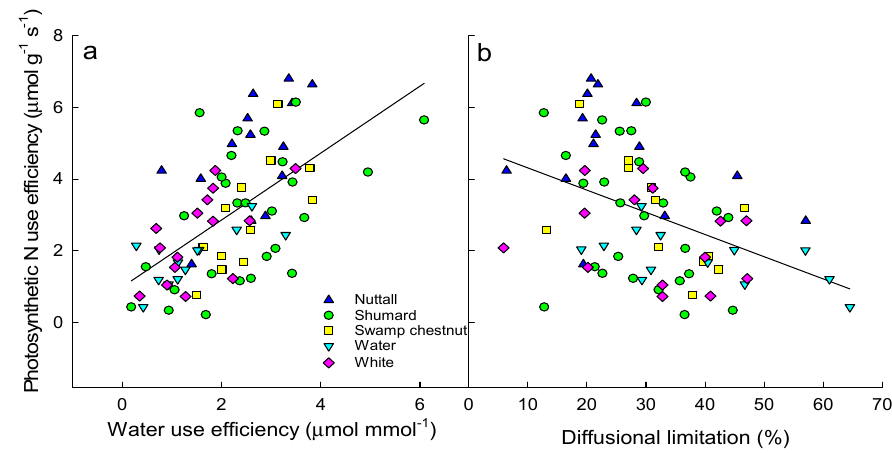
Figure 2. Photosynthetic nitrogen use efficiency (PNUE; μ mol g − 1 s − 1 ) vs. ( a ) instantaneous water use efficiency estimated from gas exchange data (water use efficiency (WUE); μ mol mmol − 1 ; r 2 = 0.36; p < 0.0001) and ( b ) diffusional limitation to photosynthesis (%; r 2 = 0.18; p < 0.0001) for Nuttall (dark blue, up triangle), Shumard (green circle), swamp chestnut (yellow square), water (light blue down triangle), and white oak (magenta diamond).